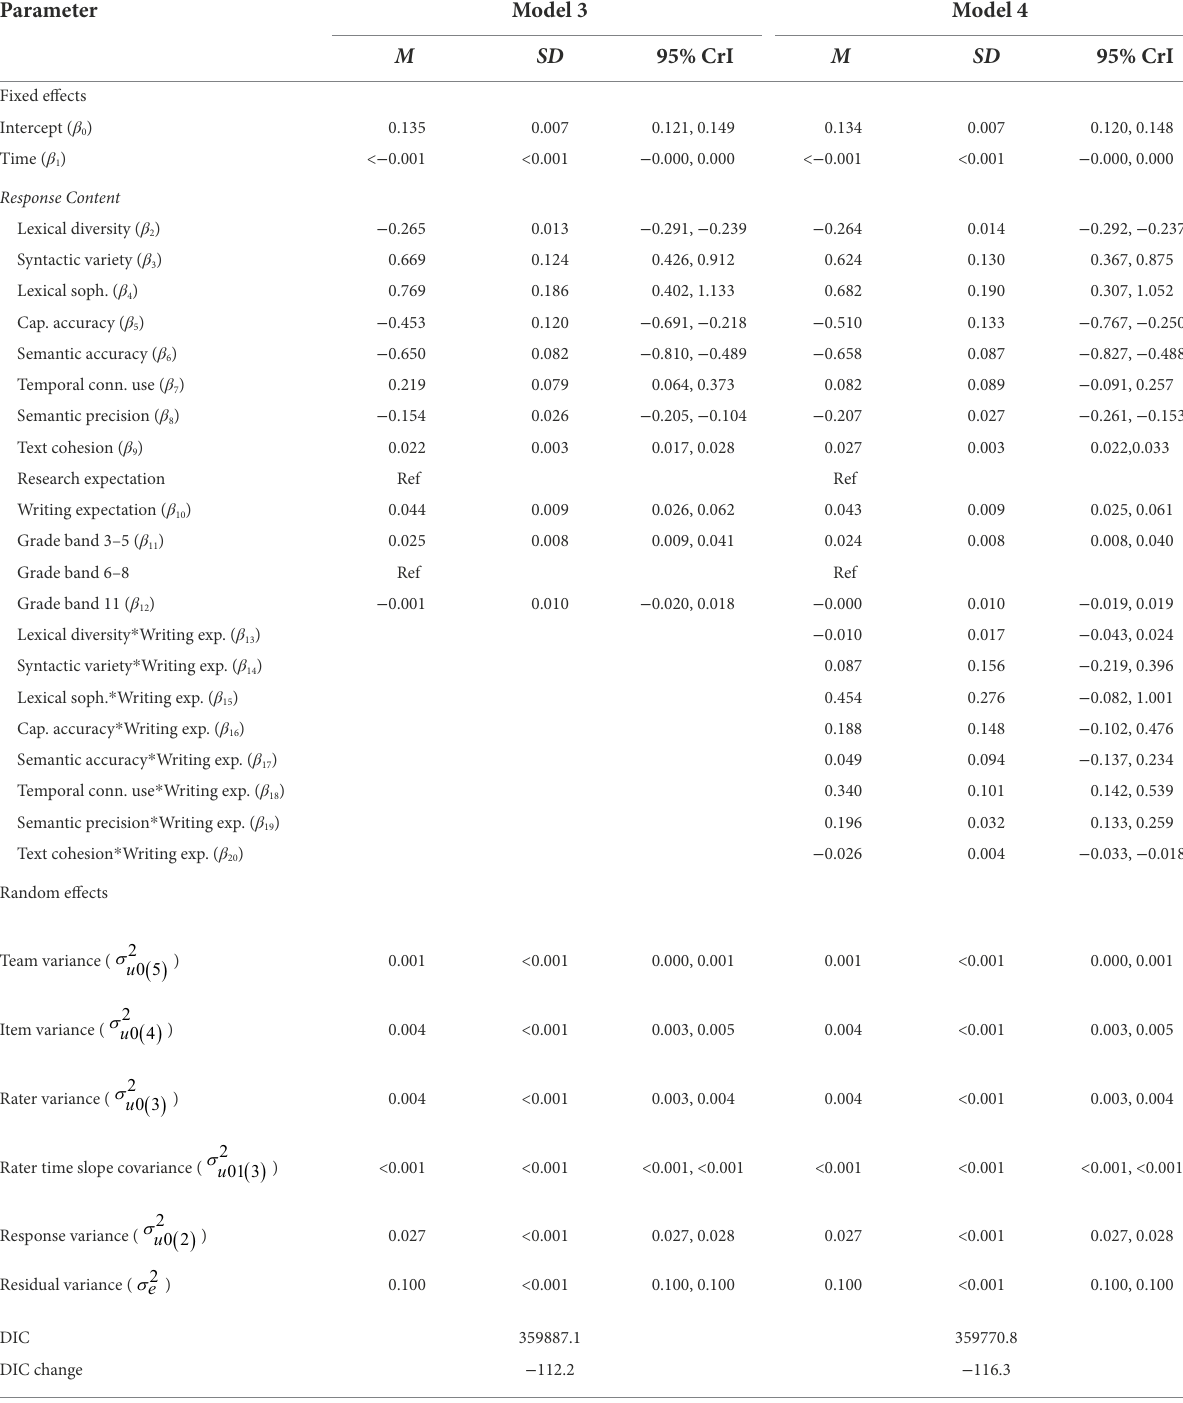
TABLE 4 Parameter estimates for models 3 and